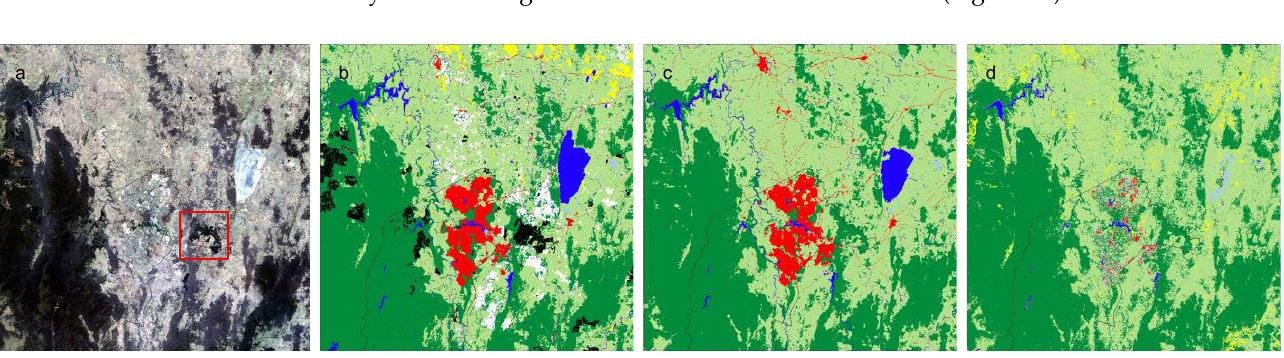
Figure 6. 2018 Landsat geomedian (true colour RGB) input ( a ), simplified label data ( b ), U-Net CNN model ( c ) and DEA Land Cover ( d ) ( b – d use the simplified classification of six land cover classes).